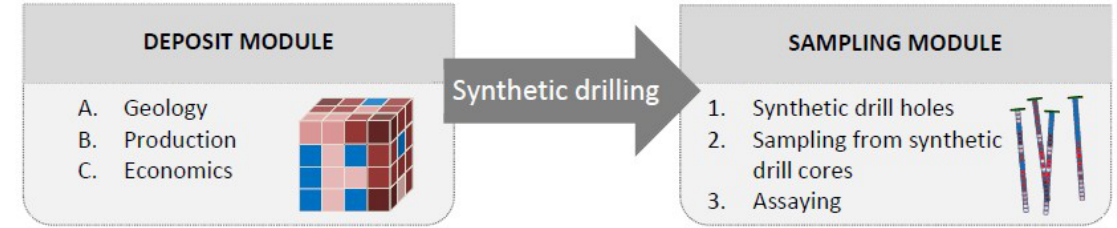
Figure 7. Structure of the sampling module and its connection to the synthetic ore body model.